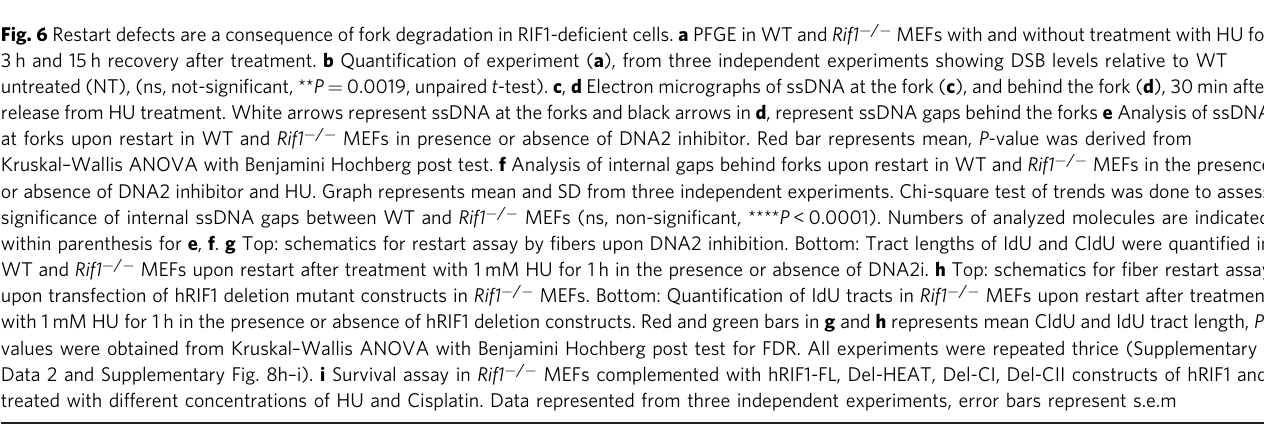
Fig. 6 Restart defects are a consequence of fork degradation in RIF1-de fi cient cells. a PFGE in WT and Rif1 − / − MEFs with and without treatment with HU for 3 h and 15 h recovery after treatment. b Quanti fi cation of experiment ( a ), from three independent experiments showing DSB levels relative to WT untreated (NT), (ns, not-signi fi cant, ** P = 0.0019, unpaired t -test). c , d Electron micrographs of ssDNA at the fork ( c ), and behind the fork ( d ), 30 min after release from HU treatment. White arrows represent ssDNA at the forks and black arrows in d , represent ssDNA gaps behind the forks e Analysis of ssDNA at forks upon restart in WT and Rif1 − / − MEFs in presence or absence of DNA2 inhibitor. Red bar represents mean, P -value was derived from Kruskal – Wallis ANOVA with Benjamini Hochberg post test. f Analysis of internal gaps behind forks upon restart in WT and Rif1 − / − MEFs in the presence or absence of DNA2 inhibitor and HU. Graph represents mean and SD from three independent experiments. Chi-square test of trends was done to assess signi fi cance of internal ssDNA gaps between WT and Rif1 − / − MEFs (ns, non-signi fi cant, **** P < 0.0001). Numbers of analyzed molecules are indicated within parenthesis for e , f . g Top: schematics for restart assay by fi bers upon DNA2 inhibition. Bottom: Tract lengths of IdU and CldU were quanti fi ed in WT and Rif1 − / − MEFs upon restart after treatment with 1 mM HU for 1 h in the presence or absence of DNA2i. h Top: schematics for fi ber restart assay upon transfection of hRIF1 deletion mutant constructs in Rif1 − / − MEFs. Bottom: Quanti fi cation of IdU tracts in Rif1 − / − MEFs upon restart after treatment with 1 mM HU for 1 h in the presence or absence of hRIF1 deletion constructs. Red and green bars in g and h represents mean CldU and IdU tract length, P - values were obtained from Kruskal – Wallis ANOVA with Benjamini Hochberg post test for FDR. All experiments were repeated thrice